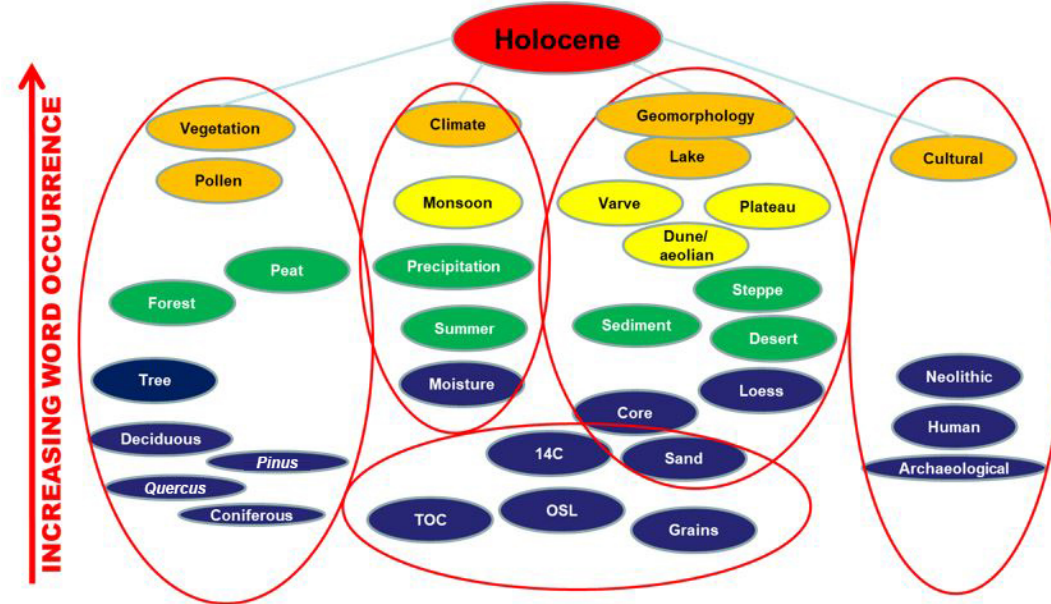
Figure 5. Topic map. Word extraction organized by number of words and topics (ovals: red – highest; blue – lowest; increasing num- ber of occurrences from bottom to top) and by four major topic groups (left – vegetation; middle left – climate; middle right – geomor- phic/sedimentologic type; right – cultural). Lower center – analysis type. TOC: table of